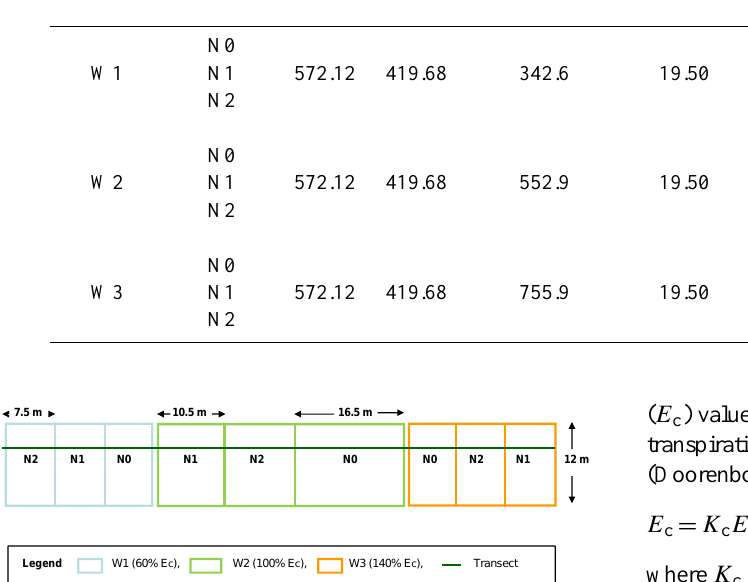
The plots were also fertilized with a total of 120 kg ha − 1 of phosphoric acid over the